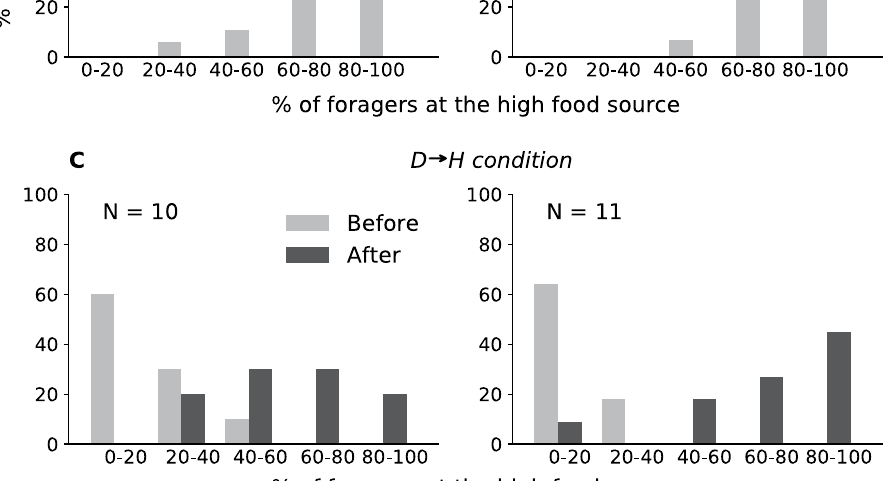
ants faced the ascendant branch (4%; N = 157) than the descendant branch (45%; N = 94) in L . niger (Table 4; two-sample binomial test, P < 0.0001). Values were similar in M . rubra : 7% (N = 145) of U-turns towards the ascending branch and 52% (N = 73) towards the descending branch (Table 4; two-sample binomial test, P < 0.0001). During the phase of exploration in the D → H condition, the results were similar for both species: the U-turn rate was approximately 10% (N = 154) towards the ascending branch and rose to 46% (N = 140) towards the descending branch in L . niger (Table 4; two-sample binomial test, P < 0.0001), while it was 10% (N = 63) towards the ascending branch and rose to 48% (N = 80) towards the descending branch in M . rubra (Table 4; two-sample binomial test, P < 0.0001). Even more surprising were the results of the U-turns in phase of recruit- ment in the D → H condition: even if a pheromone trail led L . niger foragers towards the down food source for approximately 20 mins, as it was the only one available (a few moments after having introduced sucrose in the high food source), we observed an interestingly high U-turn rate on the descending branch, approximately 41% (N = 75), while it was very low and significantly different towards the ascending branch, 3% (N = 234) (Table 4; two-sample binomial test, P < 0.0001). Observations were similar for M . rubra in the D → H condition, with a U-turn rate of 41% (N = 49) towards the down food source for approximately 20 mins, while it was only approx- imately 3% (N = 73) towards the ascending branch. In the DD control condition during the exploration phase,